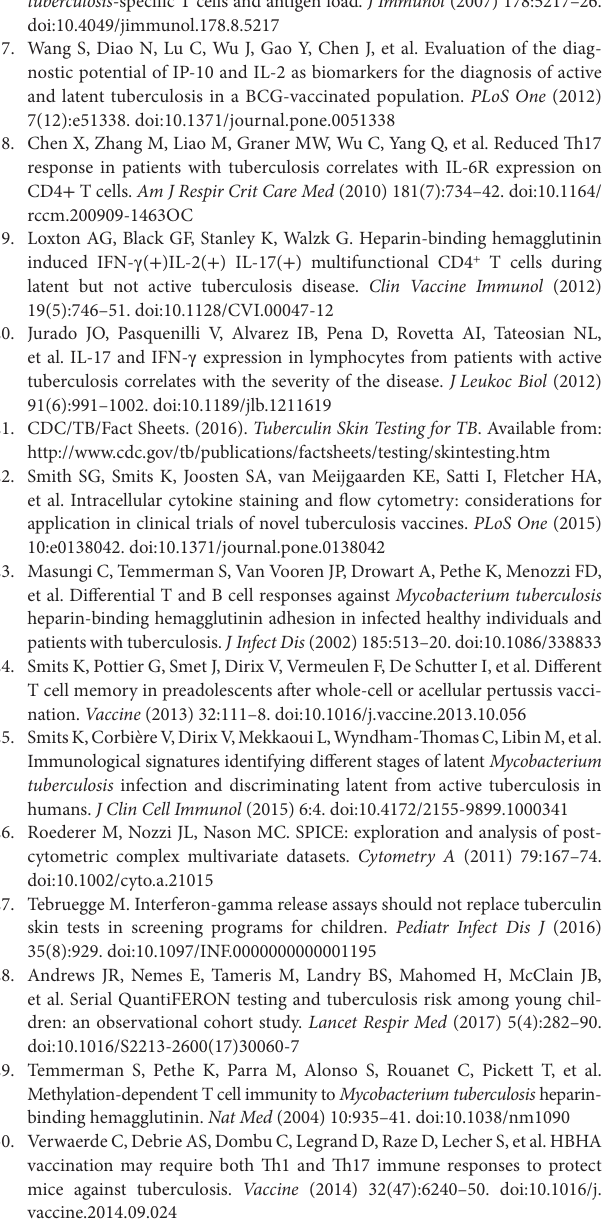
FigUre s1 | Gating strategy applied to evaluate the functional subsets of CD4 + and CD4 – T lymphocytes based on the intracellular detection of 4 cytokines. Sequential gating was done on time of acquisition (a), live cells (b), single cells (c), lymphocytes (d), CD3 + lymphocytes (e), CD3 + CD4 + (or CD4 – )T cells (f), cytokines (g–i). The respective percentages of all 15 functional subsets resulting from all pos- sible combinations of the 4 studied cytokines were calculated by boolean